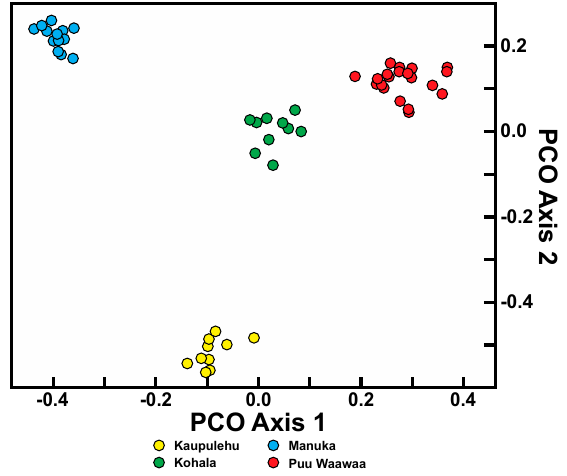
Figure 2. Principal coordinate analysis of combined random amplified polymorphic DNA and inter simple sequence repeats dataset using all scored markers for Chrysodracon hawaiiensis . PCO axis 1 and 2 accounted for 18.8% and 18.2% of the variation, respectively.